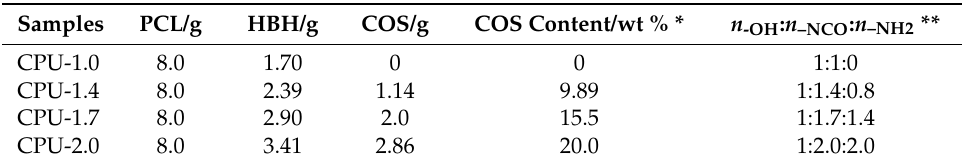
Table 1. The basic formulations and chitooligosaccharide (COS) content of chitooligosaccharide-based polyurethane